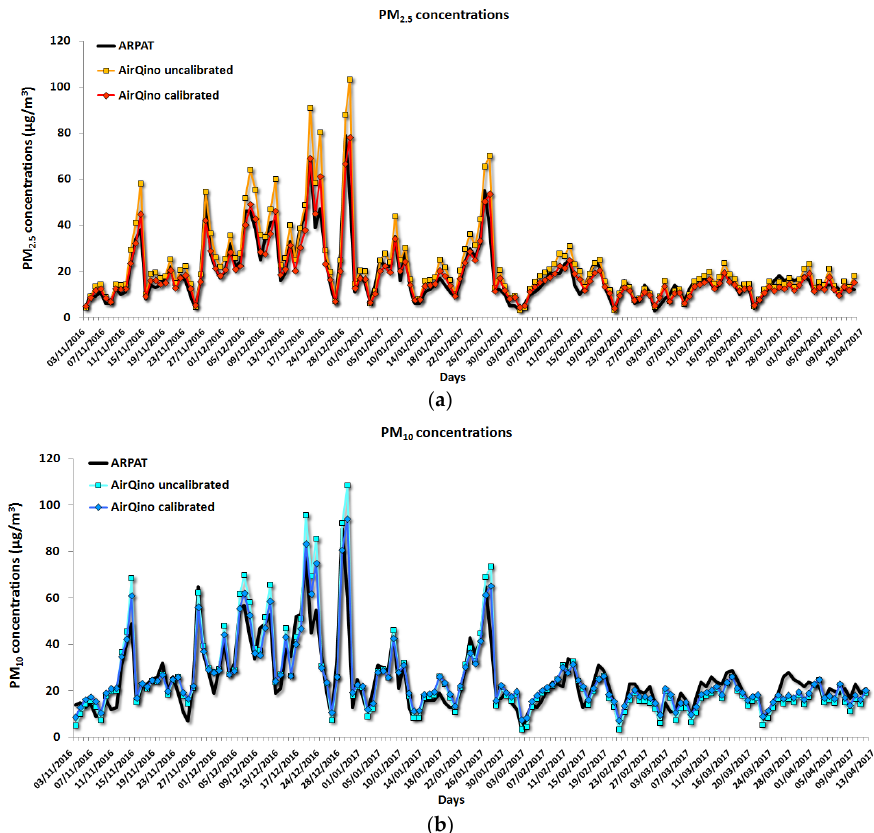
Figure 11. Comparison between 24-h averaged ( a ) PM 2.5 and ( b ) PM 10 concentrations (µg/m 3 ) measured in via Bassi (Florence) by calibrated and uncalibrated AIRQino stations vs. ARPAT reference station (1 November 2016 to 15 April 2017).